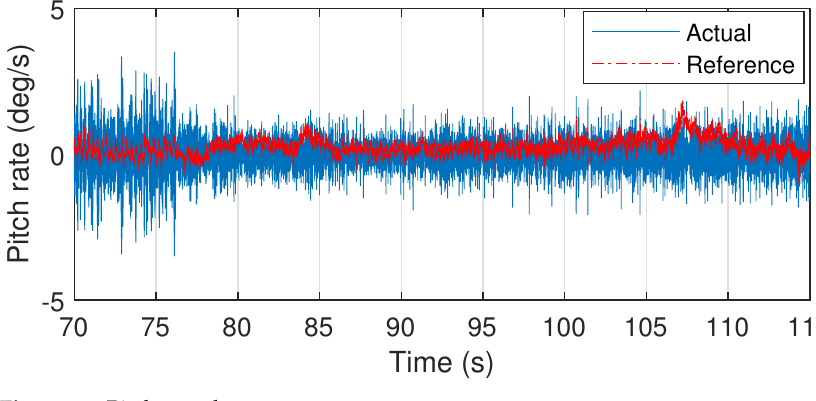
Figure 25. Pitch angular rate.